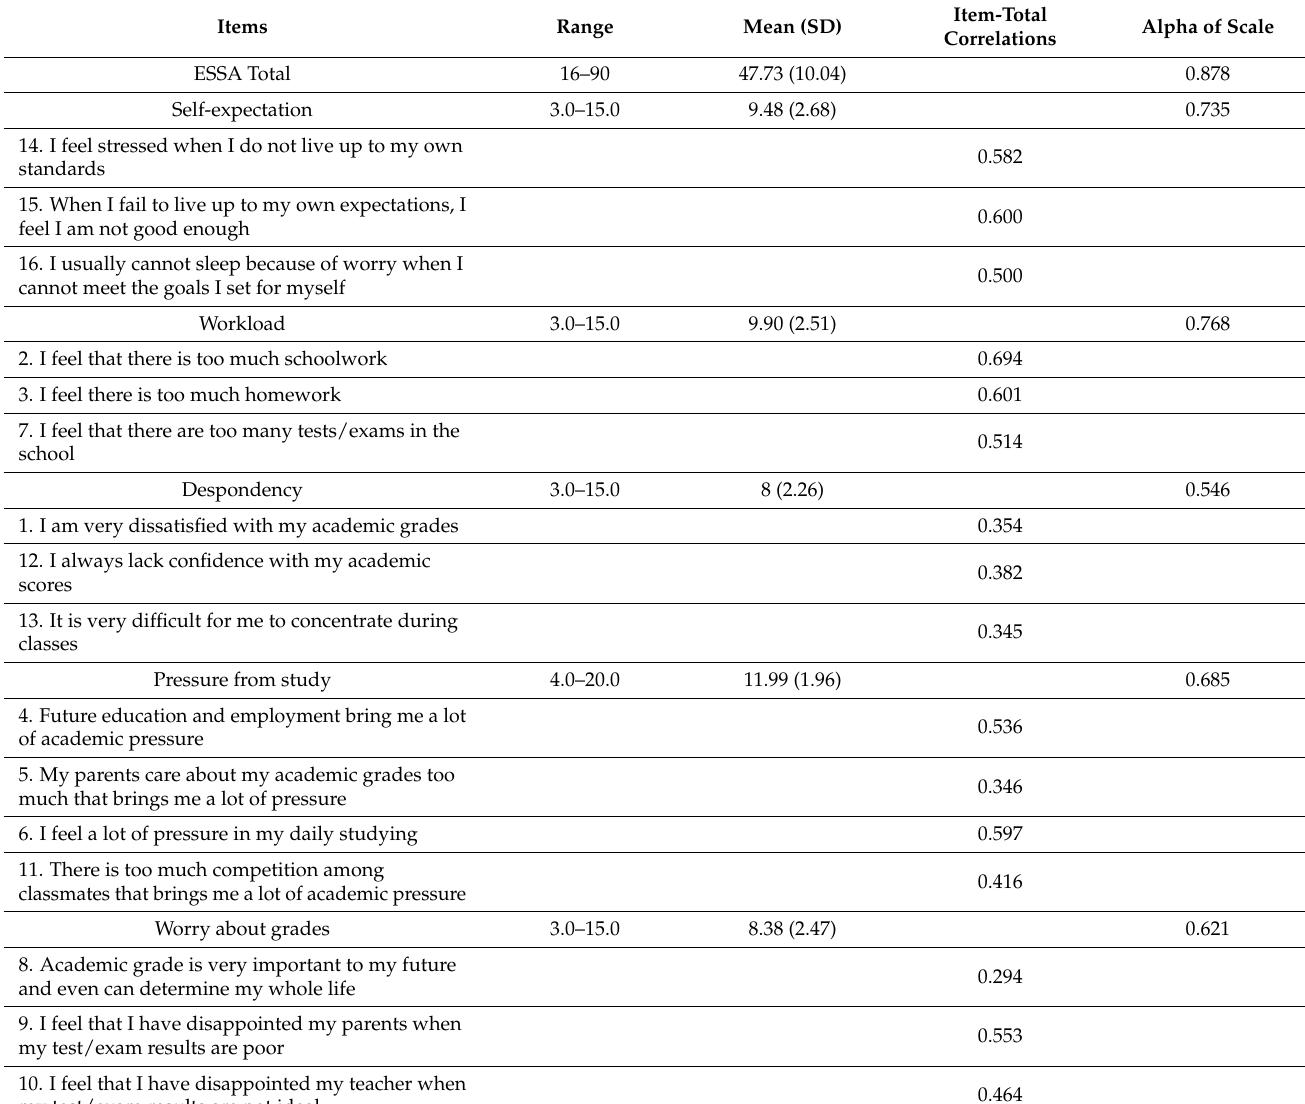
Table 4. Range, mean, standard deviation, correlations (item-total correlation), and Cronbach’s α coefficients for the ESSA questionnaire